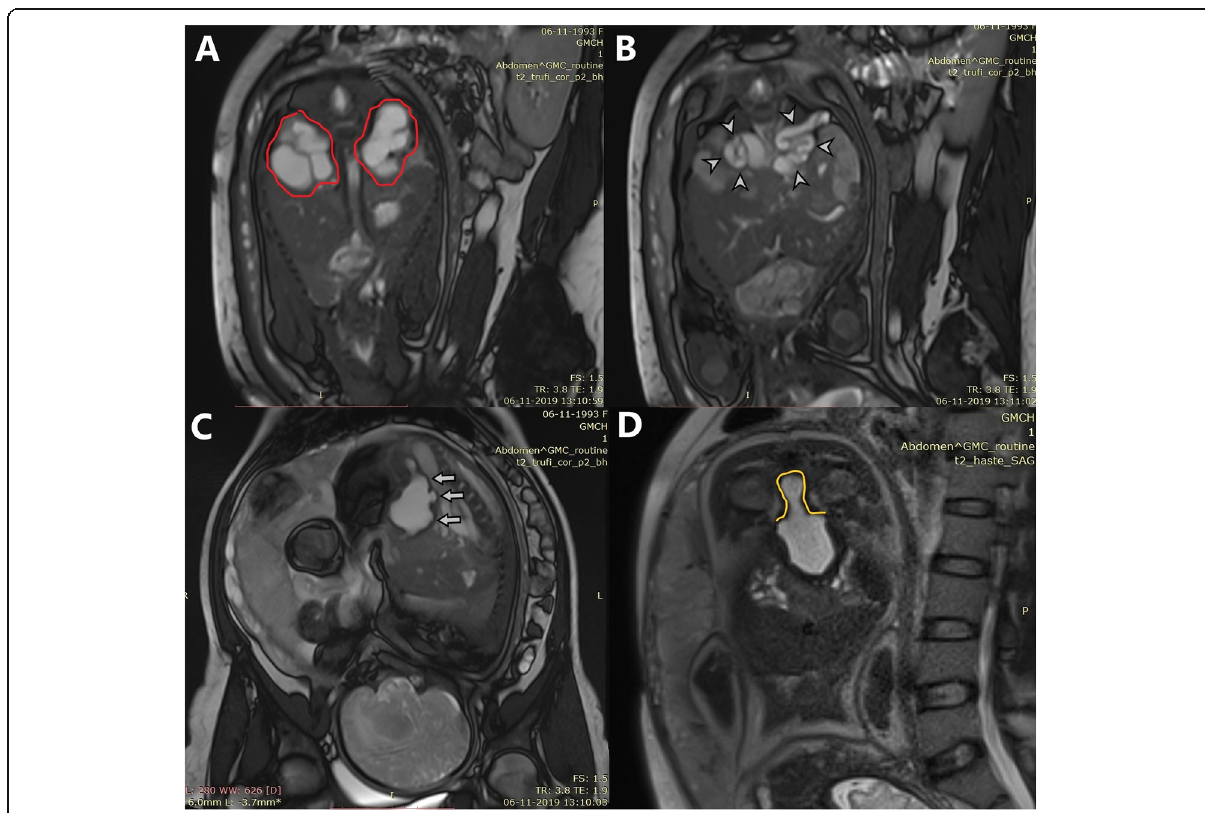
Fig. 5 Posterior urethral valves: maternal age: 26years; period of gestation: 39weeks 0days; coronal T2 TRUFI images ( a , b ) showing gross bilateral hydroureteronephrosis (red tracing in a and arrowheads in b ). T2 TRUFI sagittal ( c ) showing trabeculated bladder outline and the T2 HASTE Coronal image ( d ) showing “ typical key hole appearance ” of the dilated posterior urethra (yellow trace). There is also evidence of